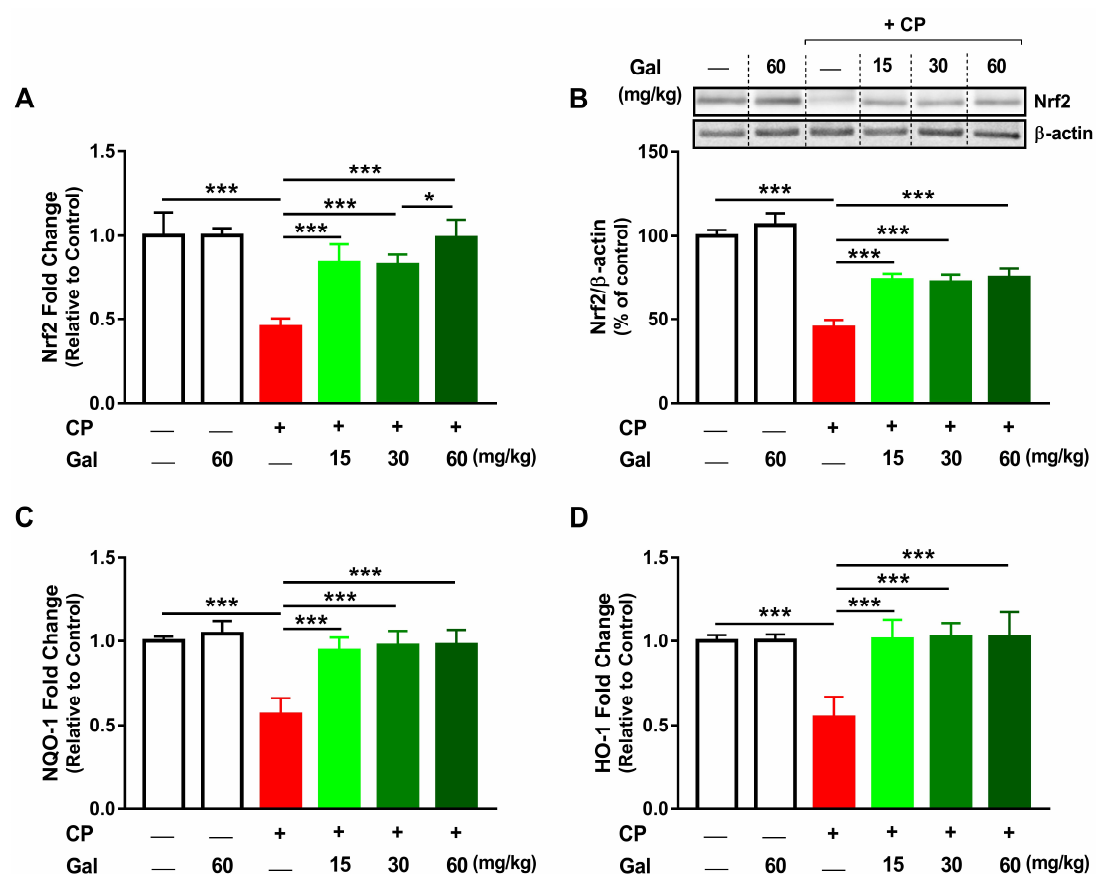
Figure 8. Galangin (Gal) activates Nrf2 / HO-1 signaling in CP-intoxicated rats. Gal increased ( A ) Nrf2 mRNA, ( B ) Nrf2 protein, ( C ) NQO-1 mRNA, and ( D ) HO-1 mRNA in liver of CP-induced rats. Data are mean ± SEM, ( N = 6). * P < 0.05 and *** P < 0.001.